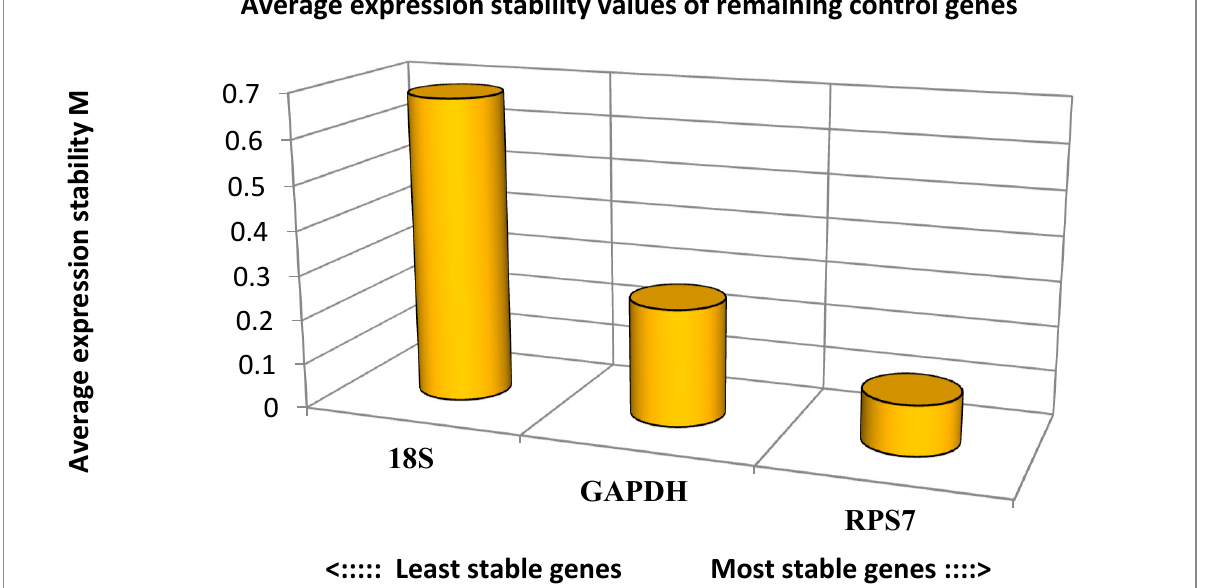
Figure 8. Expression stability analysis of reference genes in breast muscle tissue of turkeys. The most stably expressed genes have lower M values.